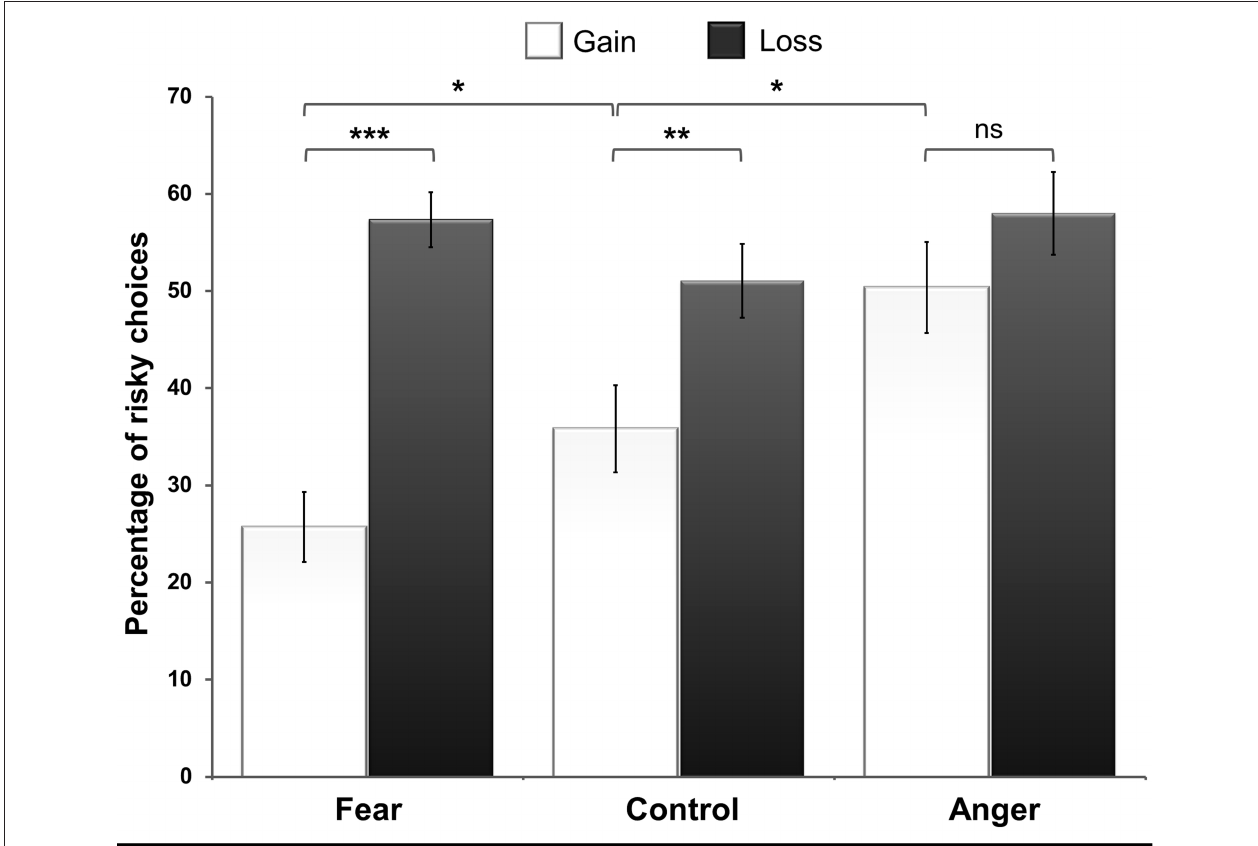
FIGURE 2 | The percentage of risky choices in the incidental fear condition, control condition and incidental anger condition in the gain and the loss frames, *p < 0.05, **p = 0.005, ***p < 0.001, ns = not